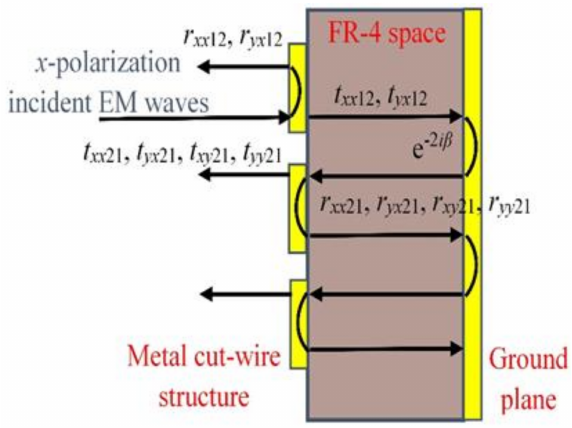
Figure 2. Schematic of multiple reflections and transmissions in a Fabry-Perot-like resonance cavity for polarization conversion.